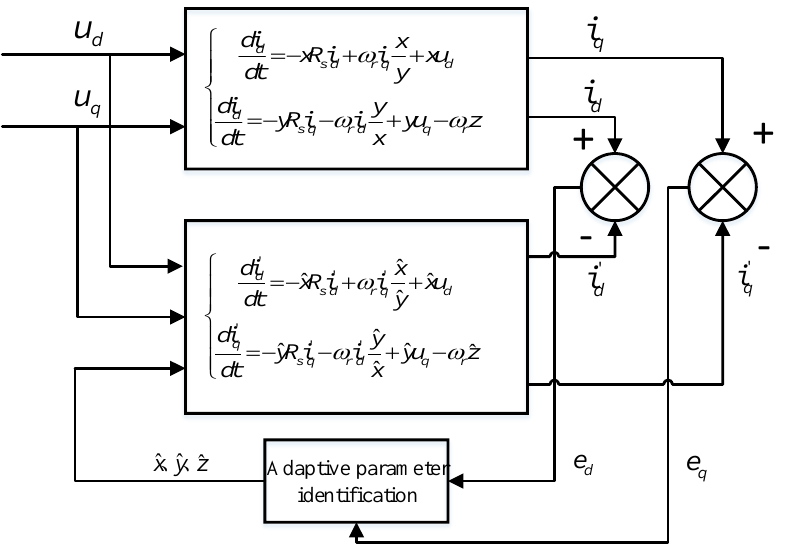
Figure 4. Block diagram of adaptive rate system.